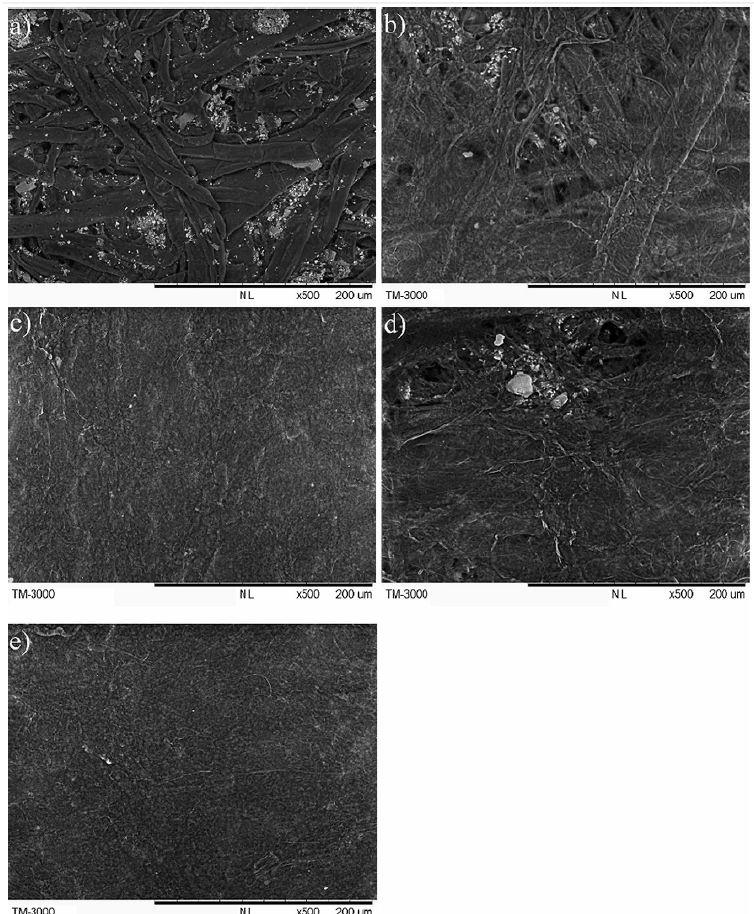
Figure 5. SEM images of CNF-coated paper:( a ) uncoated base paper; paper coated with 2% ( b ) rCNF and ( c ) gCNF along with CMC, respectively; paper coated with 3% ( d ) rCNF and ( e ) gCNF along with